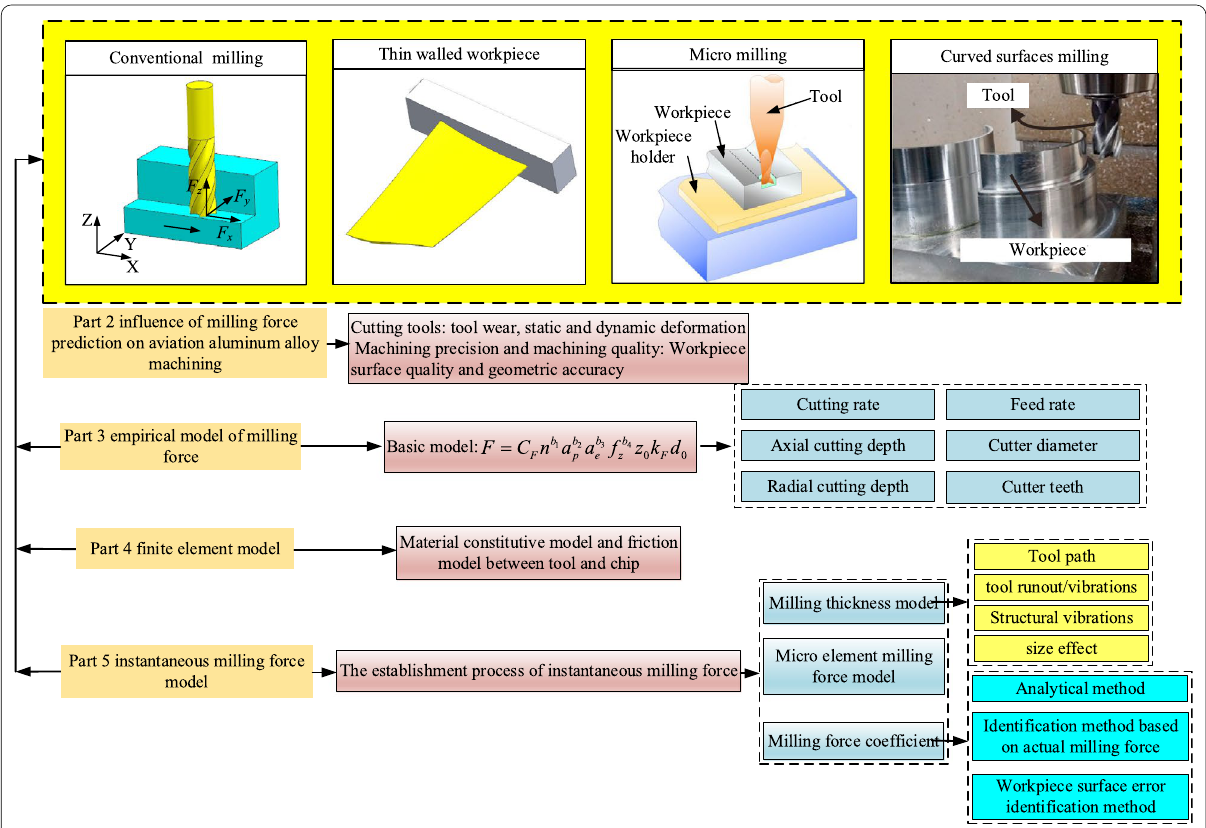
Figure 1 The paper